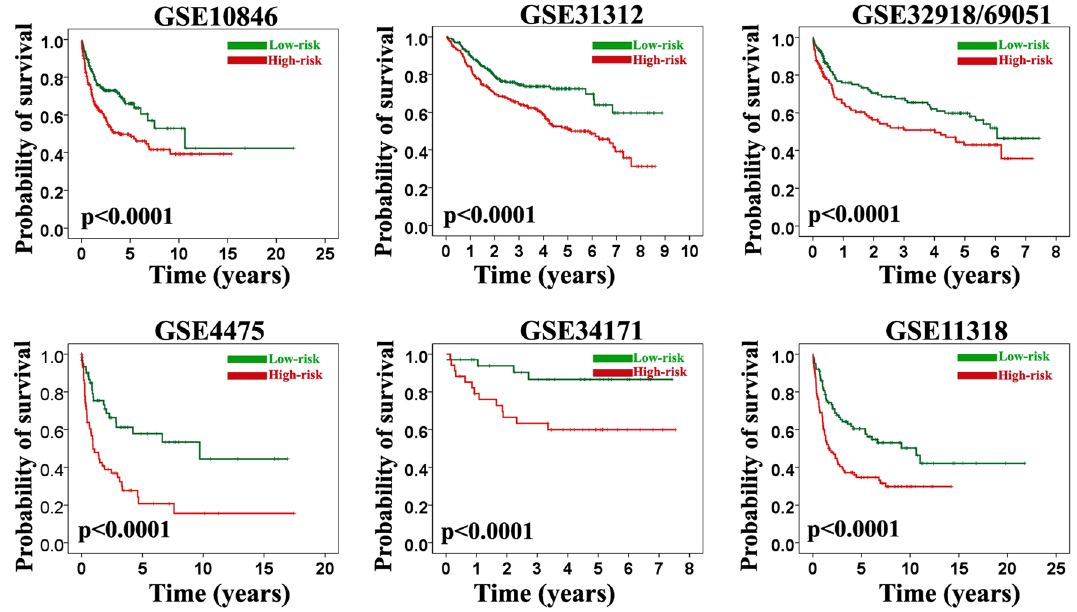
Figure 2. Kaplan–Meier survival analysis of the RTN1 in various gene expression datasets. This gene was found to be significantly associated with the overall survival at a P value < 0.0001 in all datasets.